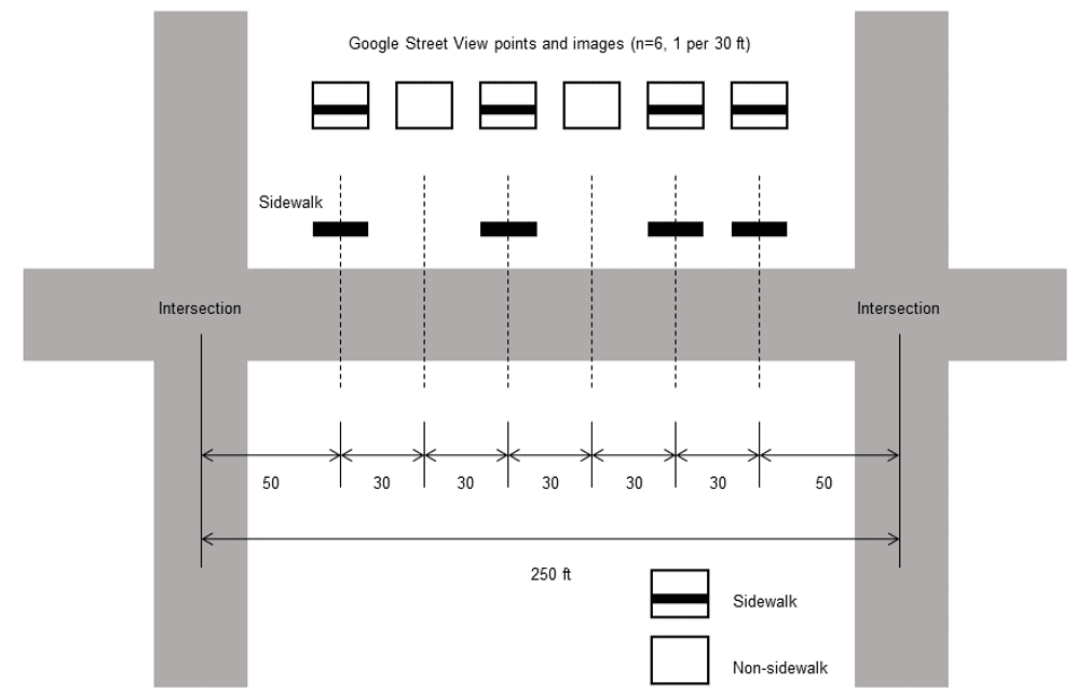
Figure 3. Street-level sidewalk classification illustration.